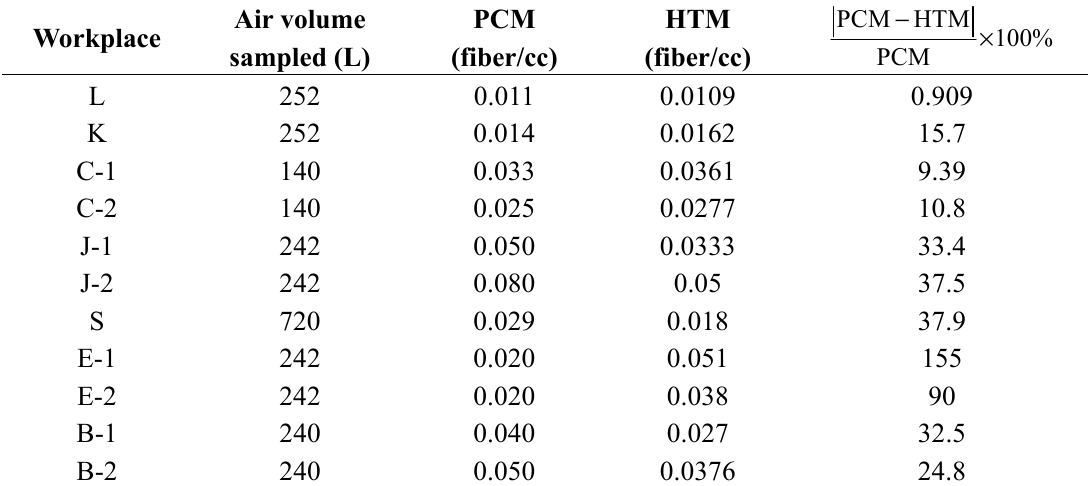
Table 2. Comparison of fiber concentration measured by PCM and HTM for on-site airborne asbestos